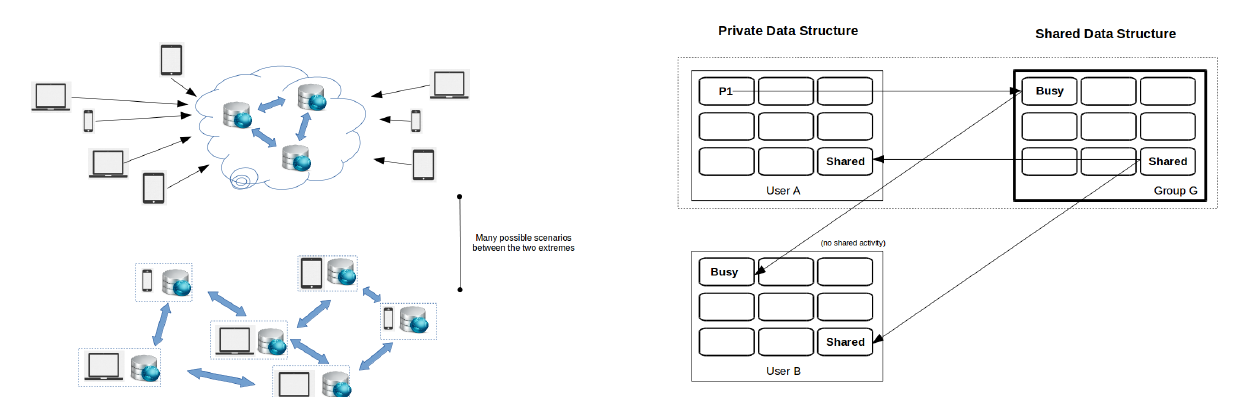
Figure 7. Computation in the Cloud (top) and computation at the edges (bottom) assuming replicated databases.